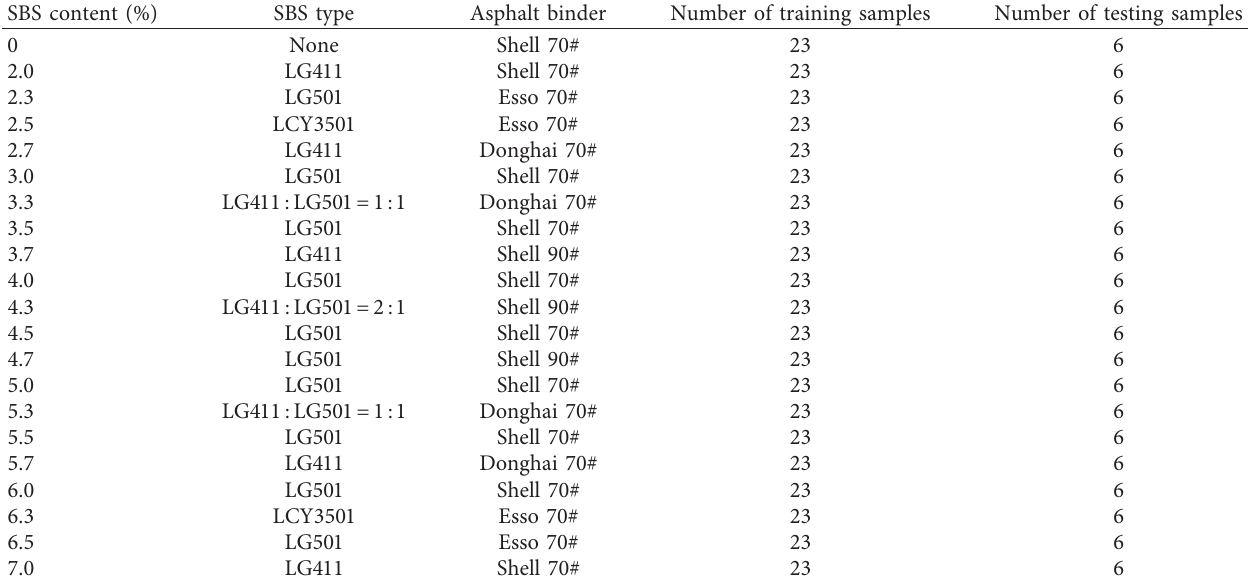
Table 4: Sample information for database.